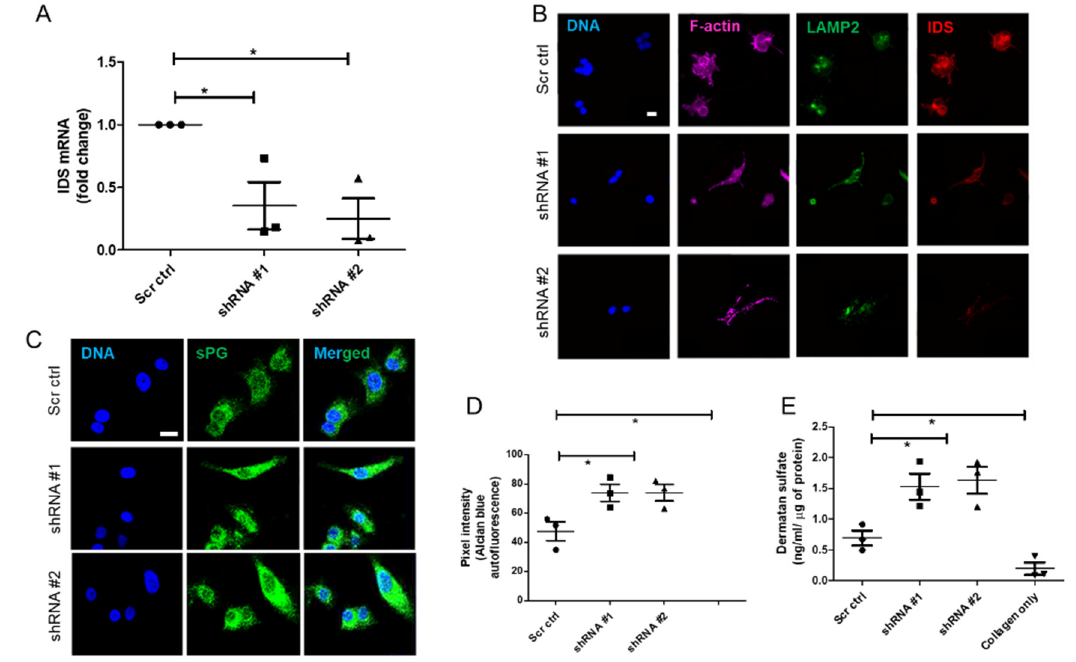
Figure 3. Decrease in IDS levels increases DS levels and alters the shape of MCF-7 cells. ( A ) Graphical representation showing a downregulation of IDS mRNA levels in MCF-7 cells upon lentiviral transduction of 2 shRNA clones, compared with scrambled control shRNA transduction, using qRT-PCR. 18S rRNA was used as an internal control. ( B ) Confocal micrographs of MCF-7 cells with scrambled- and IDS-specific shRNA transduction, stained for DNA (using DAPI, blue), F-actin (using phalloidin, pink), acidic compartment (using anti-LAMP-2 antibody, green) and IDS (using anti-IDS antibody, red). Depletion of IDS is accompanied with change in shape of MCF-7 cells from polyhedral to a spindle-like morphology, scale = 10 μ m. ( C ) Confocal micrographs of MCF-7 cells with scrambled- and IDS-specific shRNA transduction, stained for DNA (using DAPI, blue), and sulfated proteoglycans (using Alcian Blue, green), scale = 20 μ m. ( D ) Scatter plot representation of the pixel intensities of autofluorescent signals from Alcian Blue staining from 3C. ( E ) Scatter plot representation depicting dermatan sulfate (DS) levels in control and IDS knockdown MCF-7 cells when cultured in 3D Type 1 collagen scaffolds, analyzed using ELISA. Levels are represented as scatter plots (mean ± SE of three independent experiments). Significance was measured using one-way ANOVA (* p < 0.05).